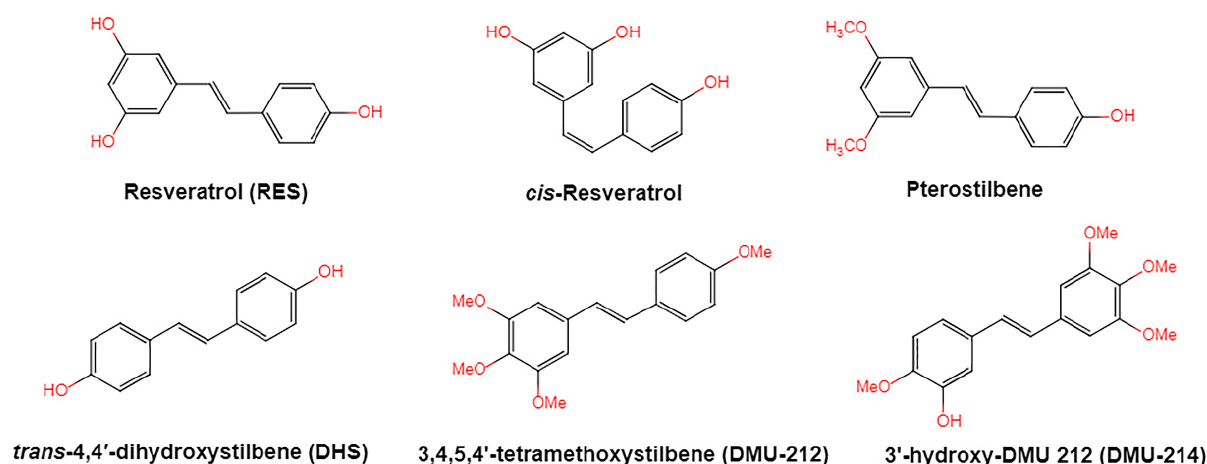
Figure 1. Structures of resveratrol, cis -Resveratrol, pterostilbene, trans -4,4 (cid:48) -dihydroxystilbene (DHS), 3,4,5,4 (cid:48) - tetramethoxystilbene (DMU-212), and 3 (cid:48) -hydroxy-3,4,5,4 (cid:48) -tetramethoxystilbene